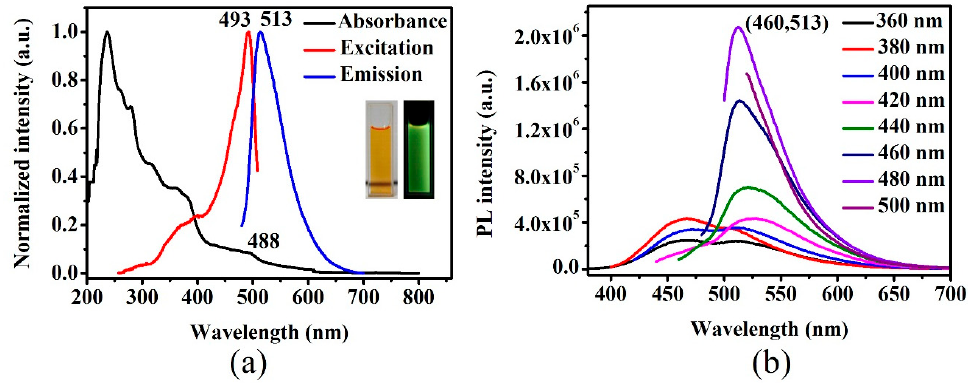
Figure 6. ( a ) UV–Vis absorption spectrum and excitation spectrum of g-CQD solution; ( b ) fluorescence spectra of g-CQD solution at different excitation wavelengths (V (EDA) = 4 mL, T = 180 °C, D r = 12 h).